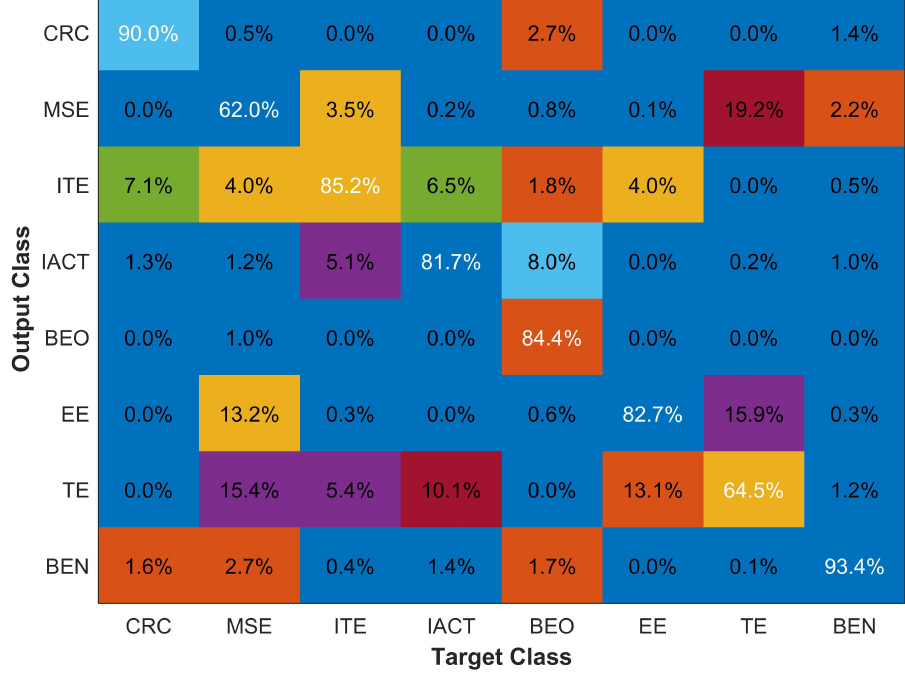
Figure 14. Classification results using a 2 m database with eight buildings.